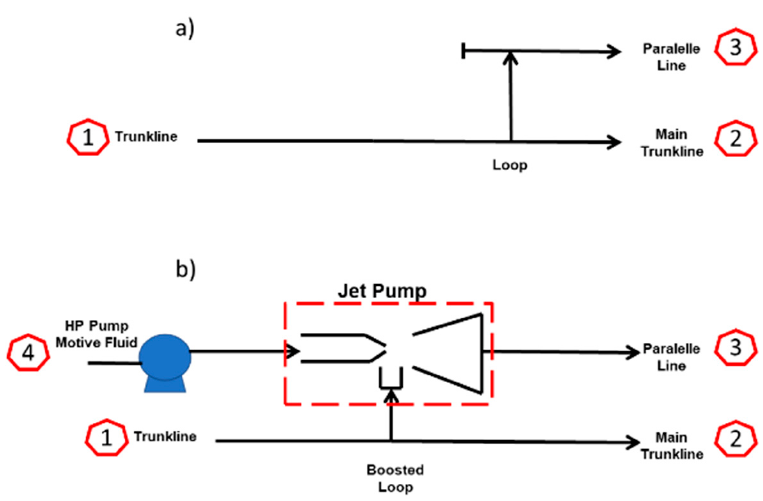
Figure 6. Booster jet pump installed in a trunkline loop scheme. ( a ) without jet pump, ( b ) with jet pump [3].